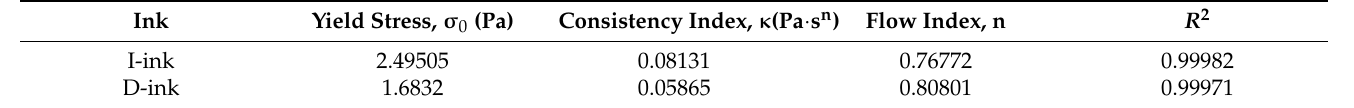
Table 4. Calculated Herschel–Bulkley parameters for the catalyst